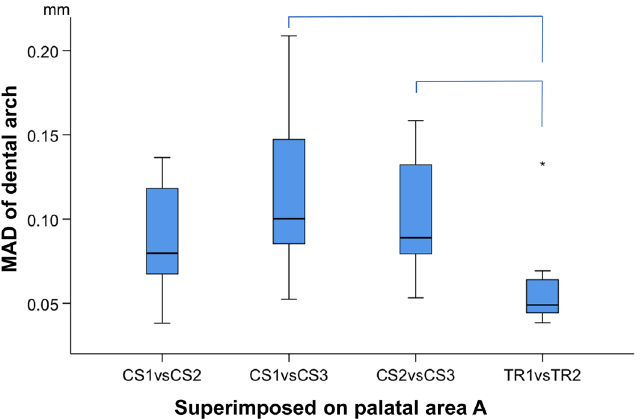
Figure 5. Box plots showing the precision (mm) of the two scanners (CS3600 and TRIOS3) measured through the MAD of the dental arch, between repeated scans superimposed on palatal area A. The upper limit of the black line represents the maximum value, the lower limit the minimum value, the box the interquartile range, and the horizontal line the median value. Outliers are shown as stars, in more extreme cases. Lines connecting pairs of box plots imply significant differences between them (Friedman test, p = 0.000, Wilcoxon Signed Ranks Test, p < 0.008, Bonferroni correction applied). CS1, CS2, CS3: CS3600 repeated scans. TR1, TR2: TRIOS3 repeated